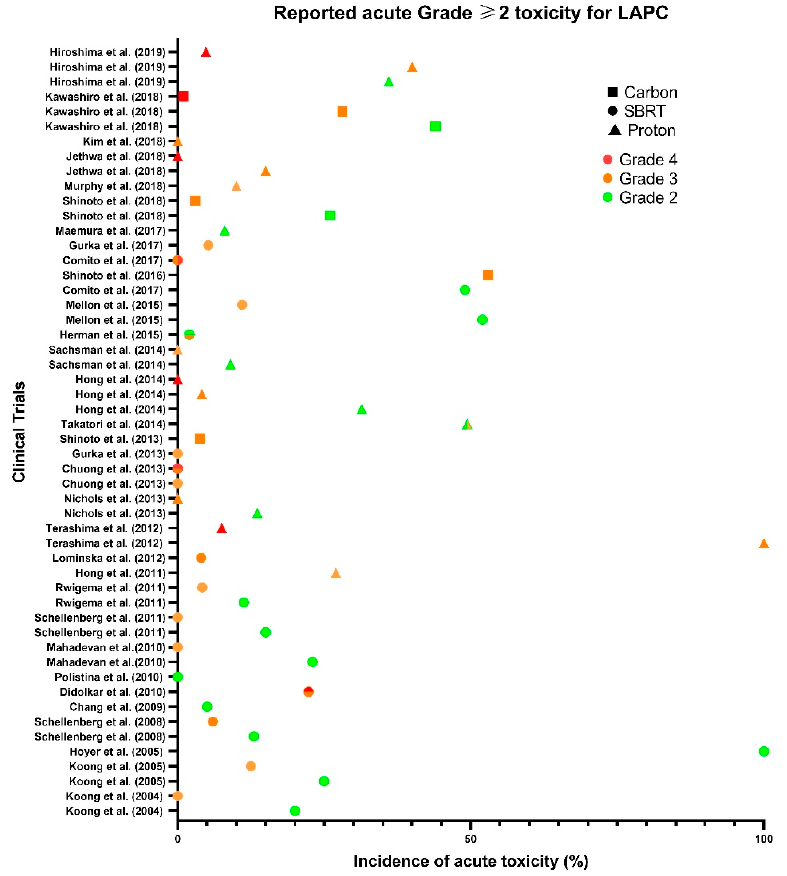
Figure 4. Reported acute Grade ≥ 2 toxicity for resectable and unresectable LAPC across SBRT ( ● ), proton ( ▲ ) and carbon ( ∎ ) clinical trials. Prescribed dose and fractionation varied across studies.